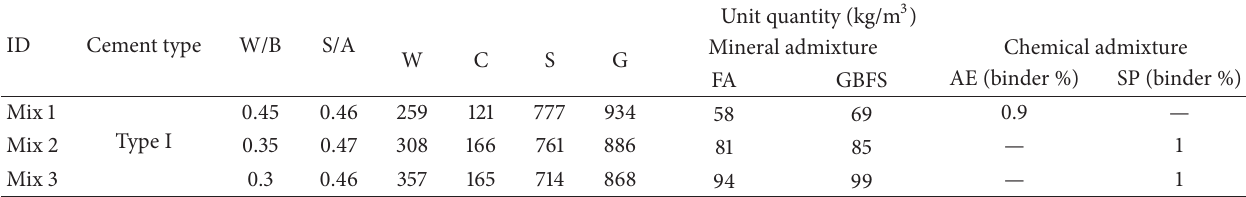
Table 1: Mix proportions of concrete design.